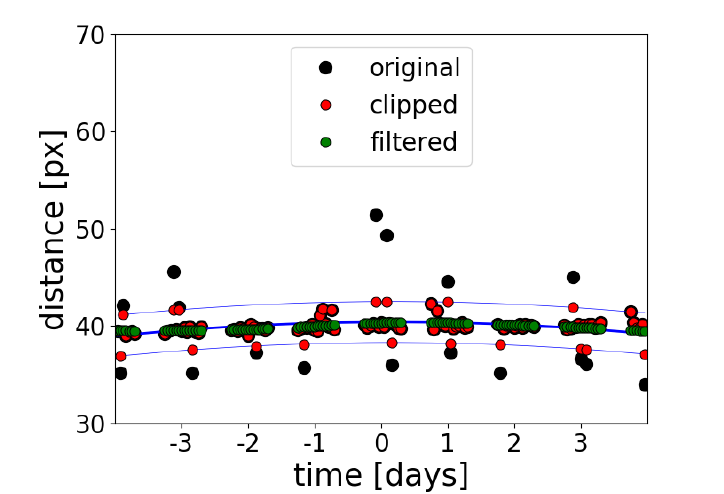
Figure 7. Illustration of time-wise clipping and filtering of matrix D k D k values, as a function of time ( j ); blue lines stand for the polynomial fitting and the limits for clipping ij (polynomial ± e t , i ); red dots are clipped data; green dots are filtered data. In this illustrative example, ∆ τ = 4days, a ∆ t = t = 2 and